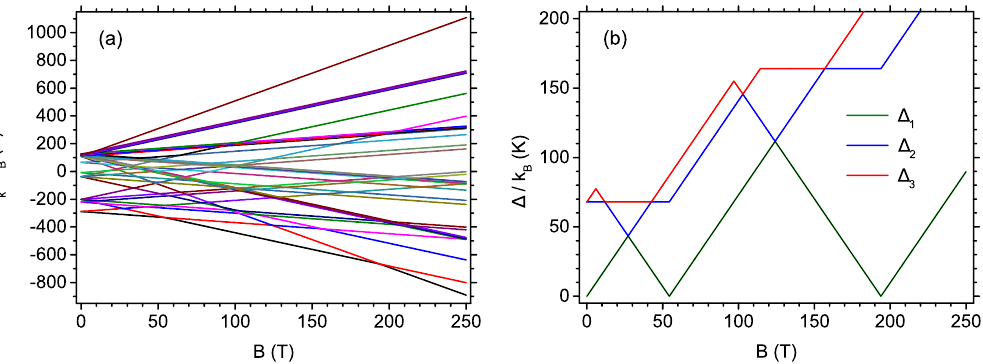
Figure 2. ( a ) The dependence of the energy levels for the system Hamiltonian on the external magnetic field; and ( b ) the dependence of the energy gaps between the ground state and a few first excited states on the external magnetic